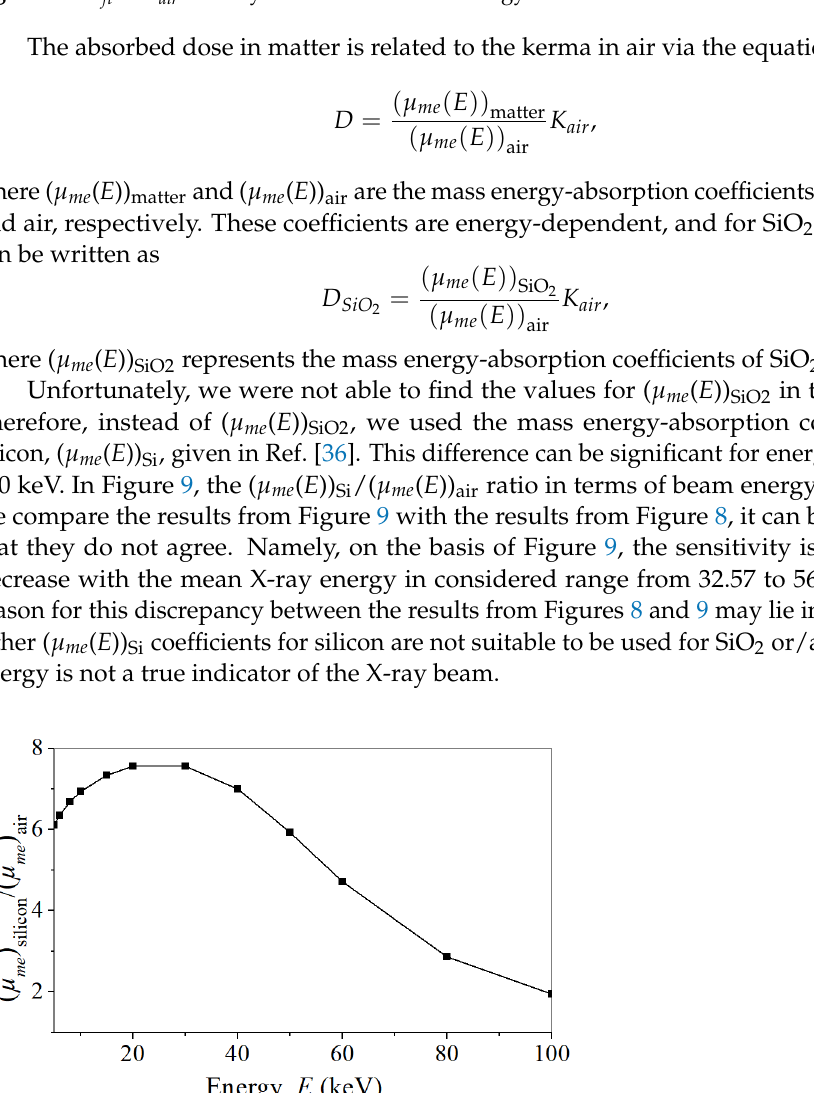
Figure 8. ∆ N ft at K air = 50 Gy versus mean beam energy.